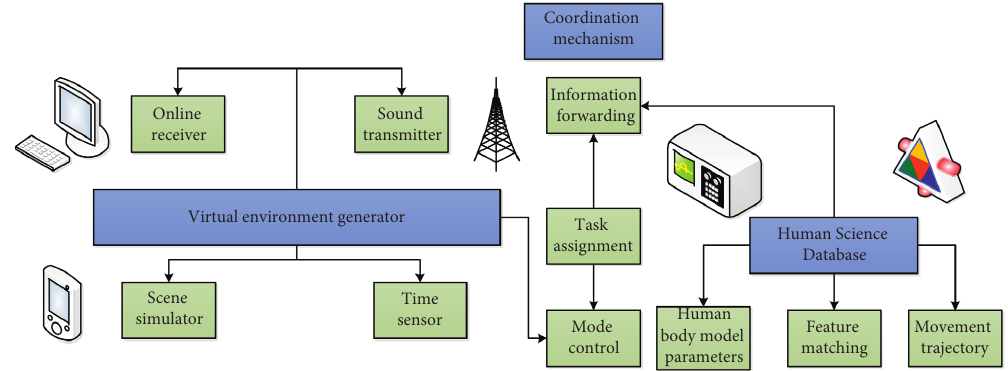
Figure 2: Human body science system framework based on VR.